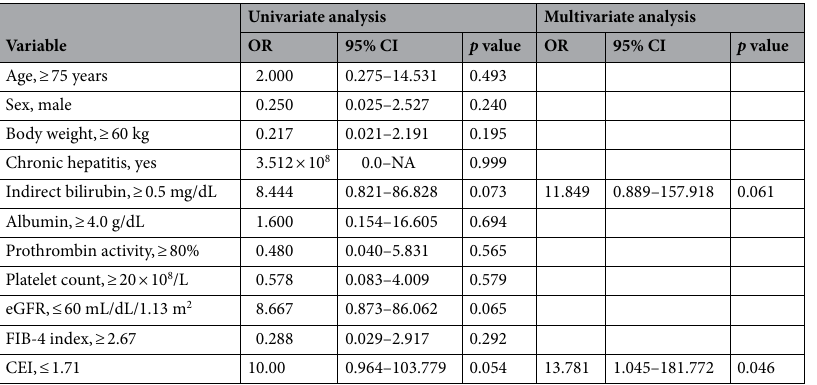
Table 5. Univariate and multivariate logistic regression analyses of baseline factors related to the development of grade ≥ 2 hyperbilirubinemia during glecaprevir/pibrentasvir treatment. CI confidence interval, CEI